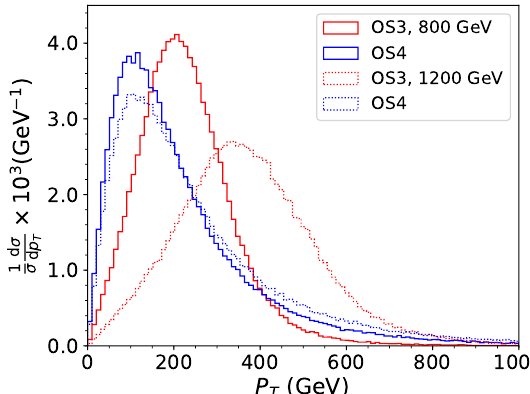
Figure 2 . The normalized p T distribution of the hadronic tops in signal divisions OS3 (red) and OS4 (blue) at parton level for benchmark points at m and m = m A = 1200 GeV, m H = 900 GeV (dashed). H ±